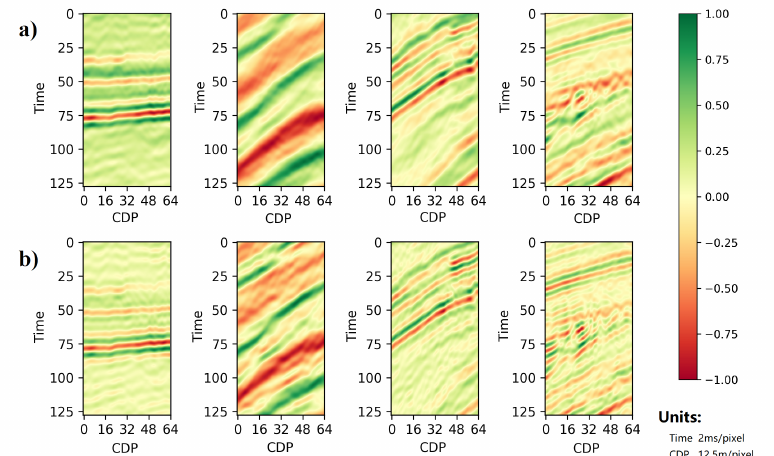
Figure 8. PSTM patches and the corresponding QPSTM patches used for network training. Panel ( a ) shows the four input patches, whereas panel ( b ) shows the corresponding learning targets (high-resolution imaging using QPSTM) from the 14,256 samples. It can be observed that the seismic events are absorbed with insufficient resolution in the conventional PSTM imaging patches, whereas the corresponding high-resolution imaging patches have more detailed information.